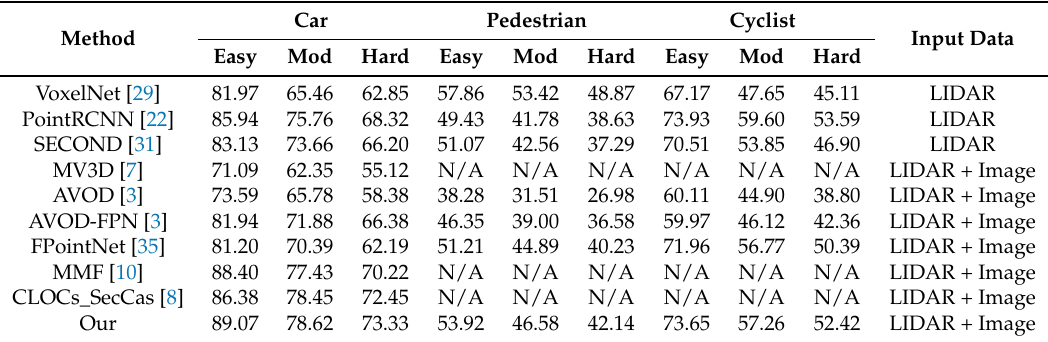
Table 6. Performance comparison with the compared methods on 3D object detection (AP, %) on the KITTI test set.